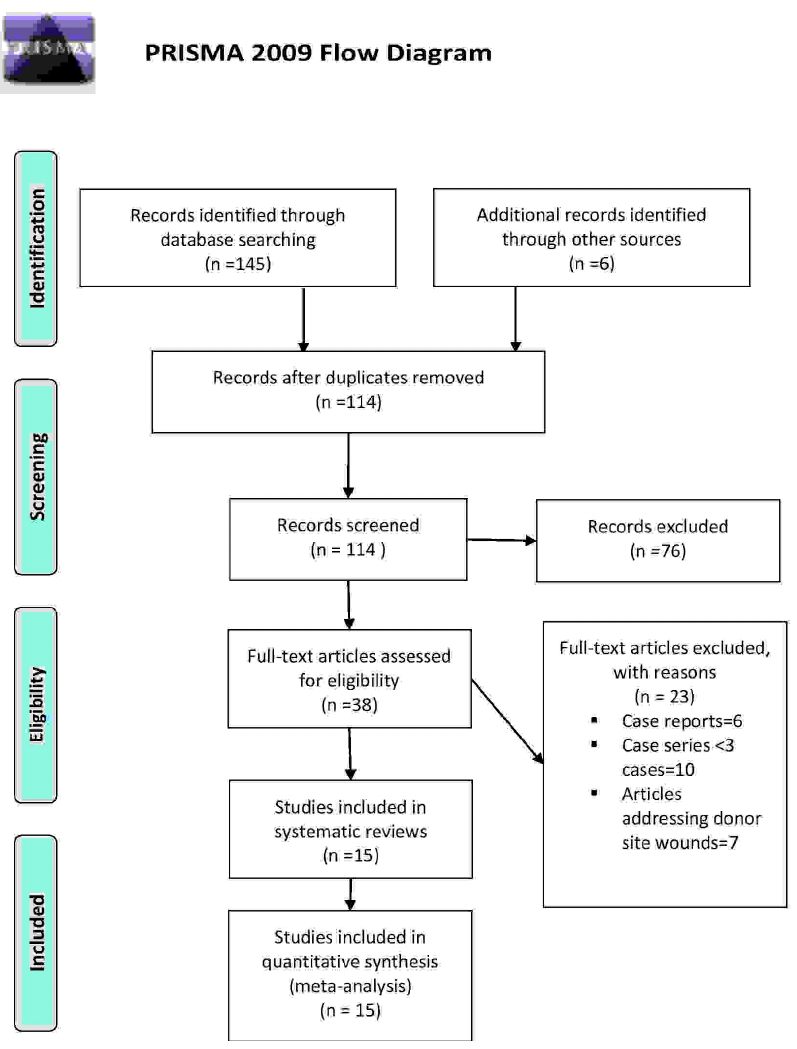
Figure 1. The flow diagram was adapted from PRISMA recommendations.